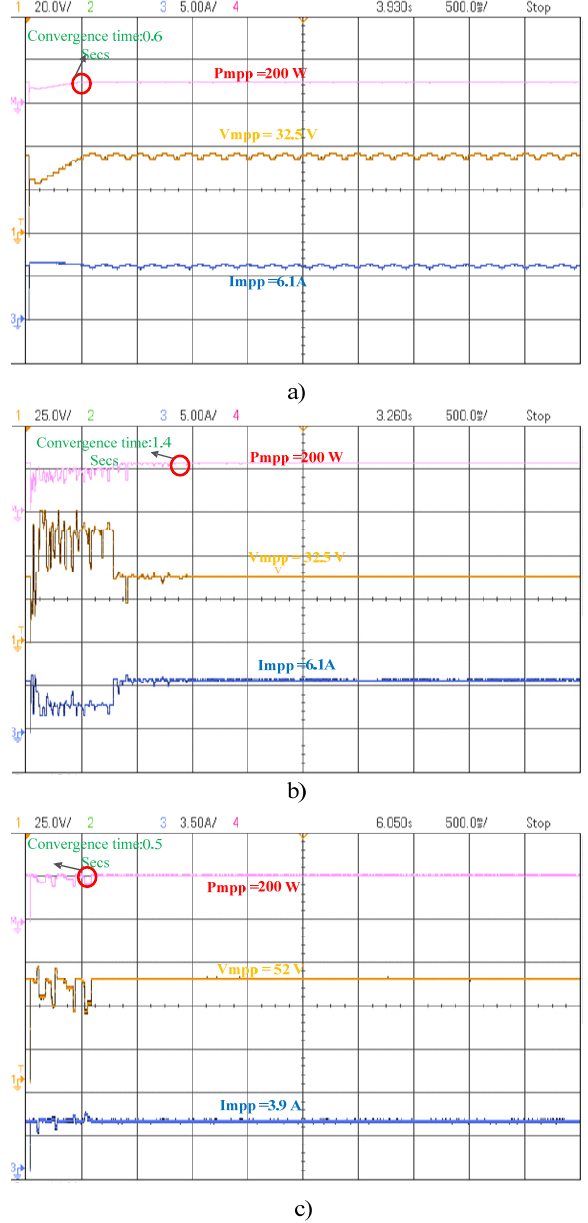
Figure 20. Experimental result for Pattern 3 under partial shading ( a ) P&O, ( b ) PSO, ( c )